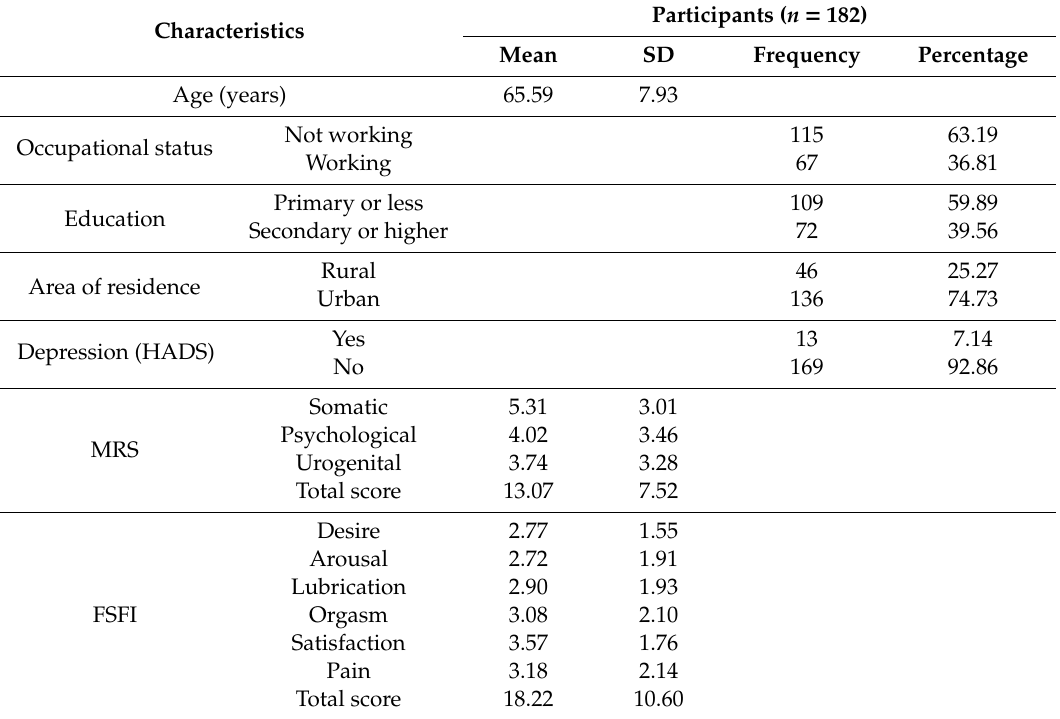
Table 1. Descriptive data of the